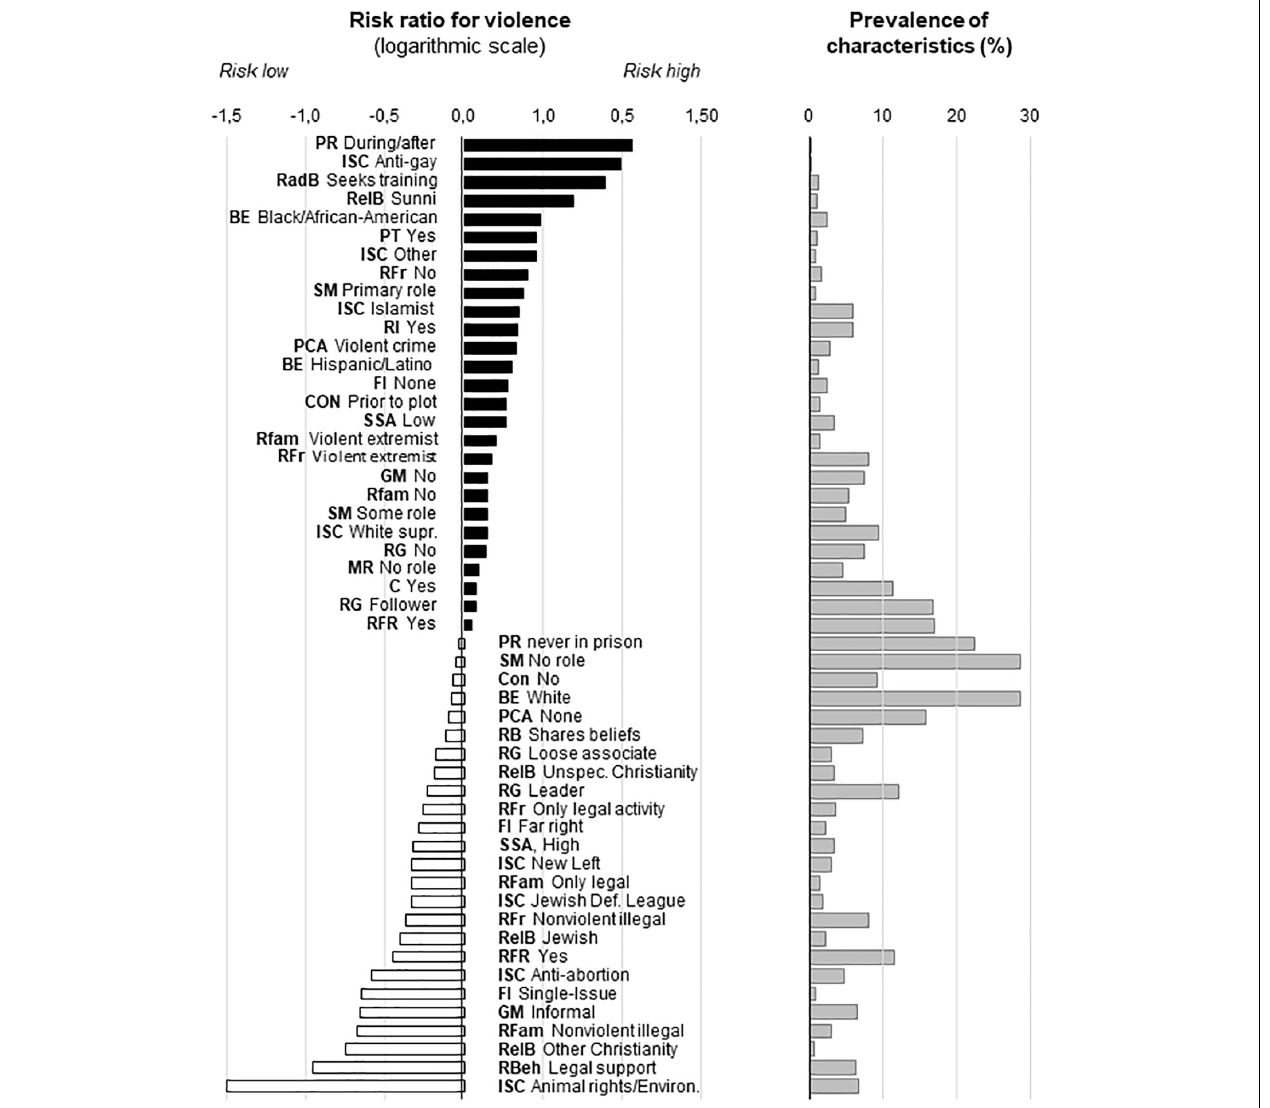
FIGURE 4 | Critical individual characteristics identified by machine learning and their share in the population. The names of variables were abbreviated (bold); those of characteristics were shortened to fit figure. The share of the characteristic was shown for the non-violent group. Abbreviations for variables. BE, Broad ethnicity; C, Clique; Con, Convert; FI, Family Ideology; GM, Group Membership; ISC, Ideological Sub Category; MR, Media Radicalization; PCA, Previous Criminal Activity; PR, Prison Radicalize; PSR, Problematic Social Relations; RadB, Radical Behaviors; RB, Radical Beliefs; RBeh, Radical Behaviors; RelB, Religious Background; RFam, Radical Family; RFL, Radicalization Far Left; RFr, Radical friend; RFR, Radicalization Far Right; RG, Role Group; RI, Radicalization Islamist; SM, Social Media; SSA, Social Stratum